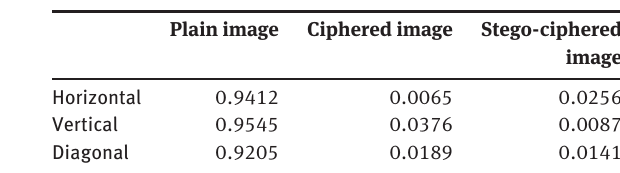
Table 4: Skull: Correlation analysis of two adjacent pixels.